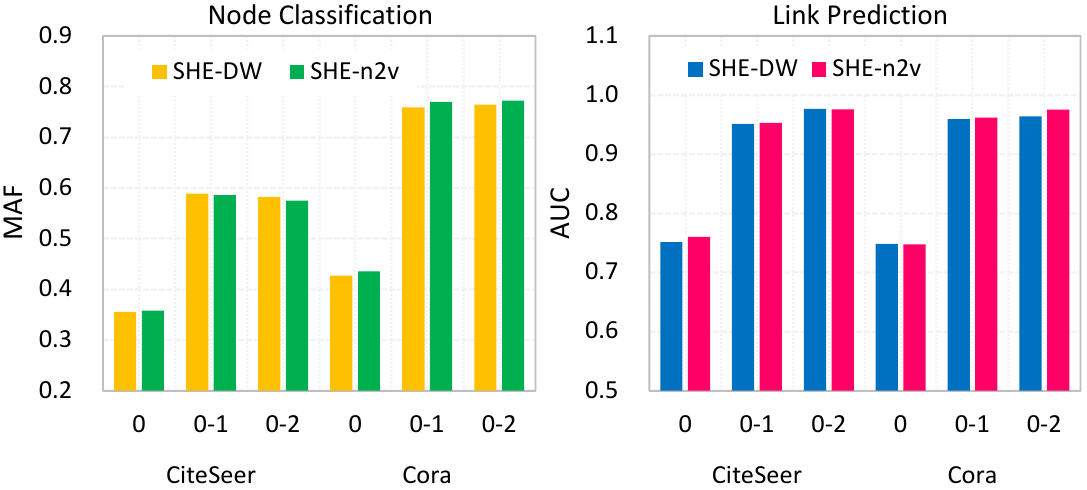
Figure 6. Results by changing the number of utilized levels in SHE based on DW and n2v,